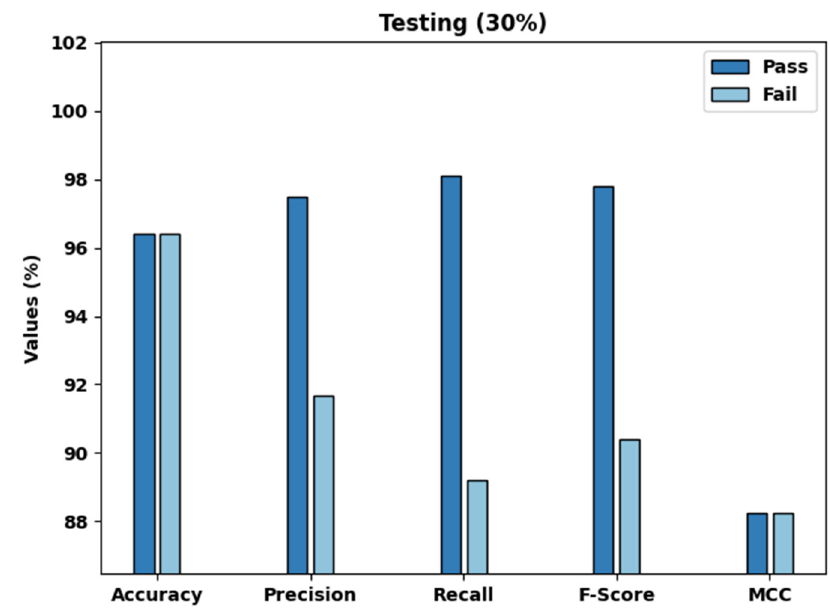
Figure 6. Result analysis of FSSML-EDM technique on 30% of testing dataset.